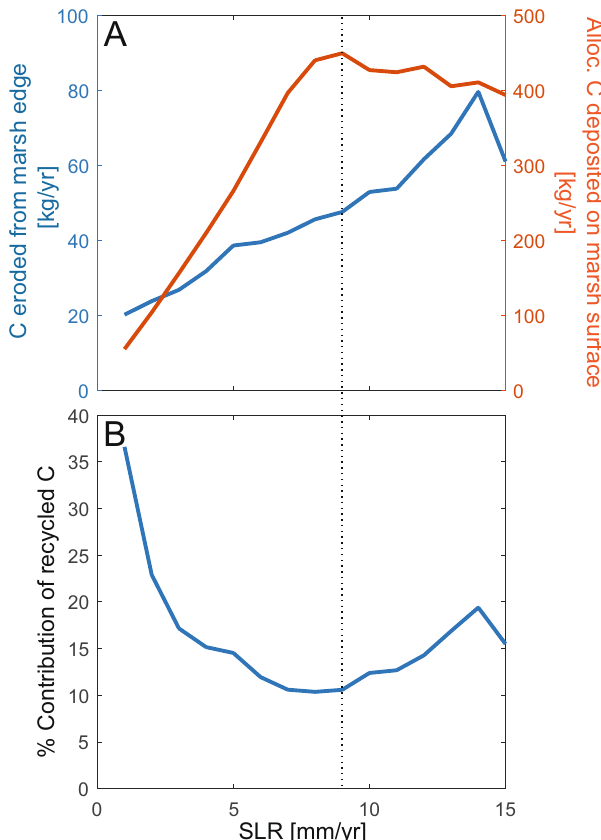
Fig. 2 | Exchange of carbon at the marsh-bay interface increases with sea level rise (SLR) rate, and recycled carbon remains important in all SLR scenarios. A Fluxes (kg yr − 1 per meter of marsh edge) of carbon eroded from the marsh edge into the bay (blue line) and of allochthonous carbon (C) deposited on the marsh platform from the bay (red line). The carbon fl ux from the marsh to the bay representsthemass fl uxofcarbonerodedfromthemarshedge,averagedoverthe last 50 years of the model experiment. The carbon fl ux from the bay to the marsh represents the mass fl ux of allochthonous carbon deposited on the marsh surface (surface deposition), averaged over the last 50 years of the model experiment. B The material eroded from the marsh edge makes up ~15% of the total carbon deposited on the marsh surface. This contribution decreases until an intermediate rate of SLR, and then increases as SLR increases. Colored envelopes show the variation (minimum and maximum) in results with suspended sediment con- centration (SSC)=20 – 60mgL − 1